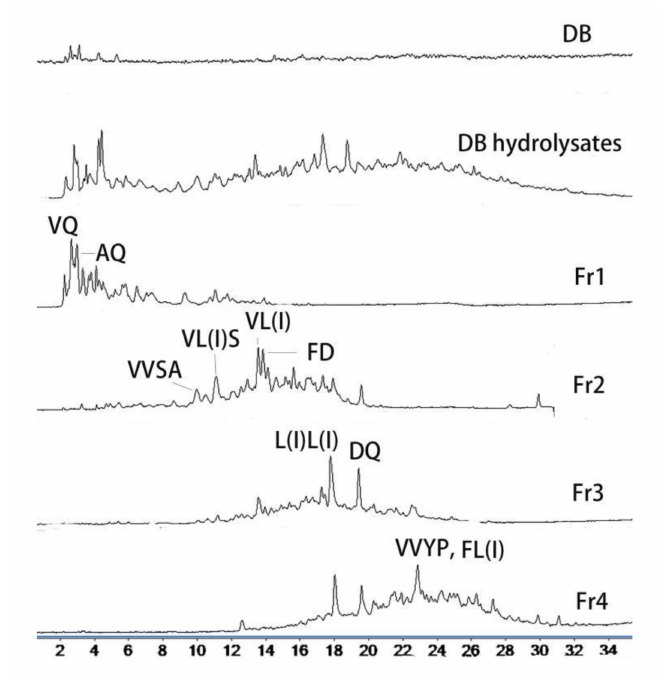
Figure 1. HPLC-MS chromatogram of deer blood (DB) hydrolysates and fractions. To investigate the anti-fatigue activities of the different peptides, the DB hydrolysates were fractioned via resin chromatography (NM 200). The resin NM 200 was a Poly(styrene- co-divinylbenzene) reversed phase material, and the surface groups were benzyls. Thus, the peptides mixture could be fractioned mainly based on the Van der Waals interaction caused by different skeleton structures. The HPLC-MS chromatogram (Figure 1) demonstrated that Fr1, Fr2, and Fr4 were comprised of different ingredients, with retention times of 3–7, 10–20, and 18–28 min, respectively. Fr3 was a mixture of Fr2 and Fr4. Thus, the DB hydrolysates were divided into three fractions of peptides with different chemical properties. The weight of Fr1 was 7.1 g, which was 47% of the total weight of enzymatic hydrolysates. Fr2, 3